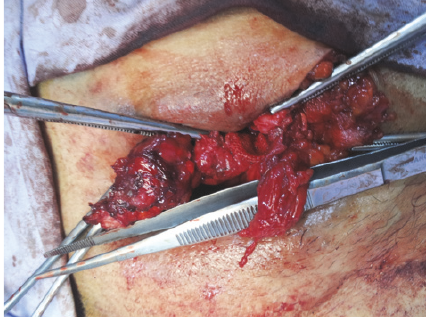
Figure 2: The vas deferens and the vessels where recognized in full length and preserved, while the mesh was totally removed.